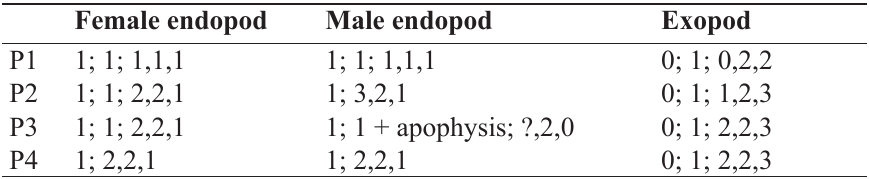
Table 6. Armature formula of P1–P4 of Kikuchicamptus gen.